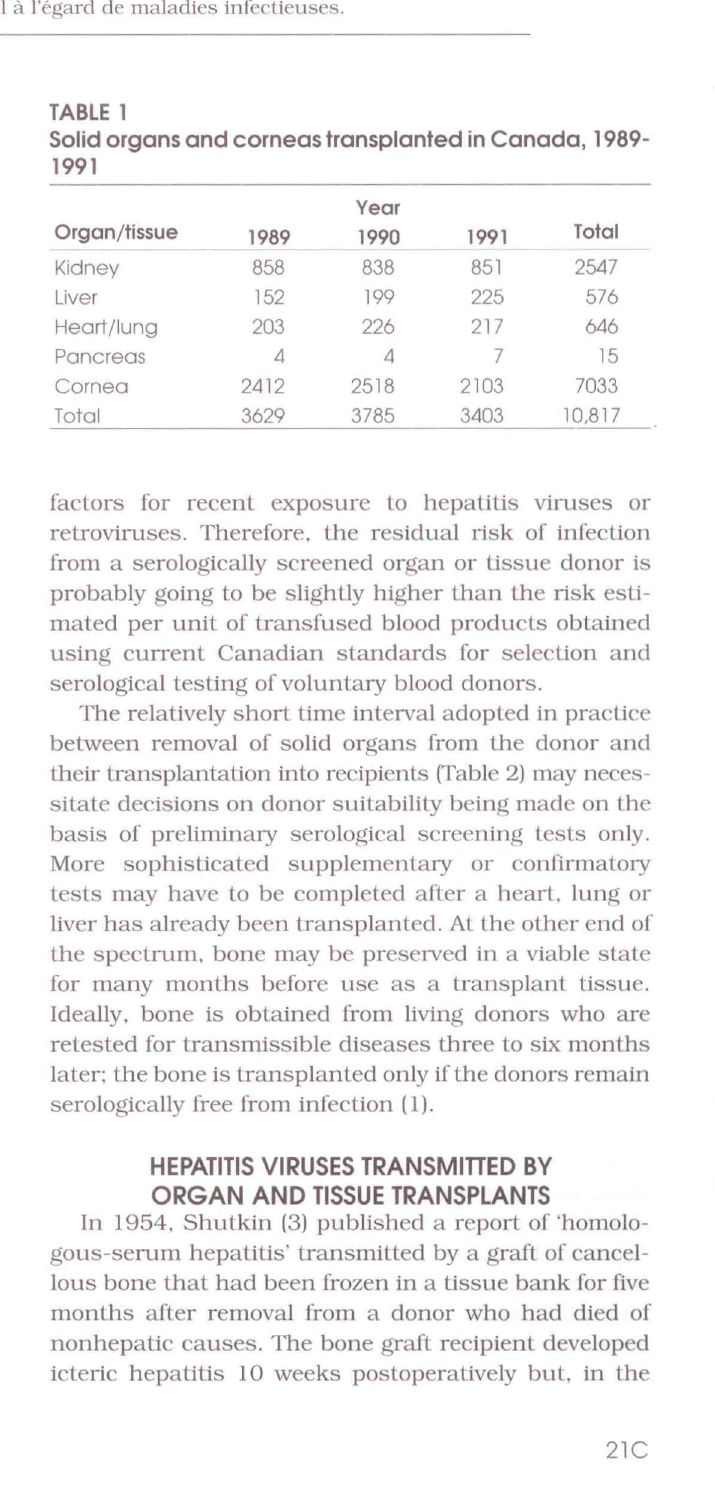
Solid organs and corneas transplanted in Canada,